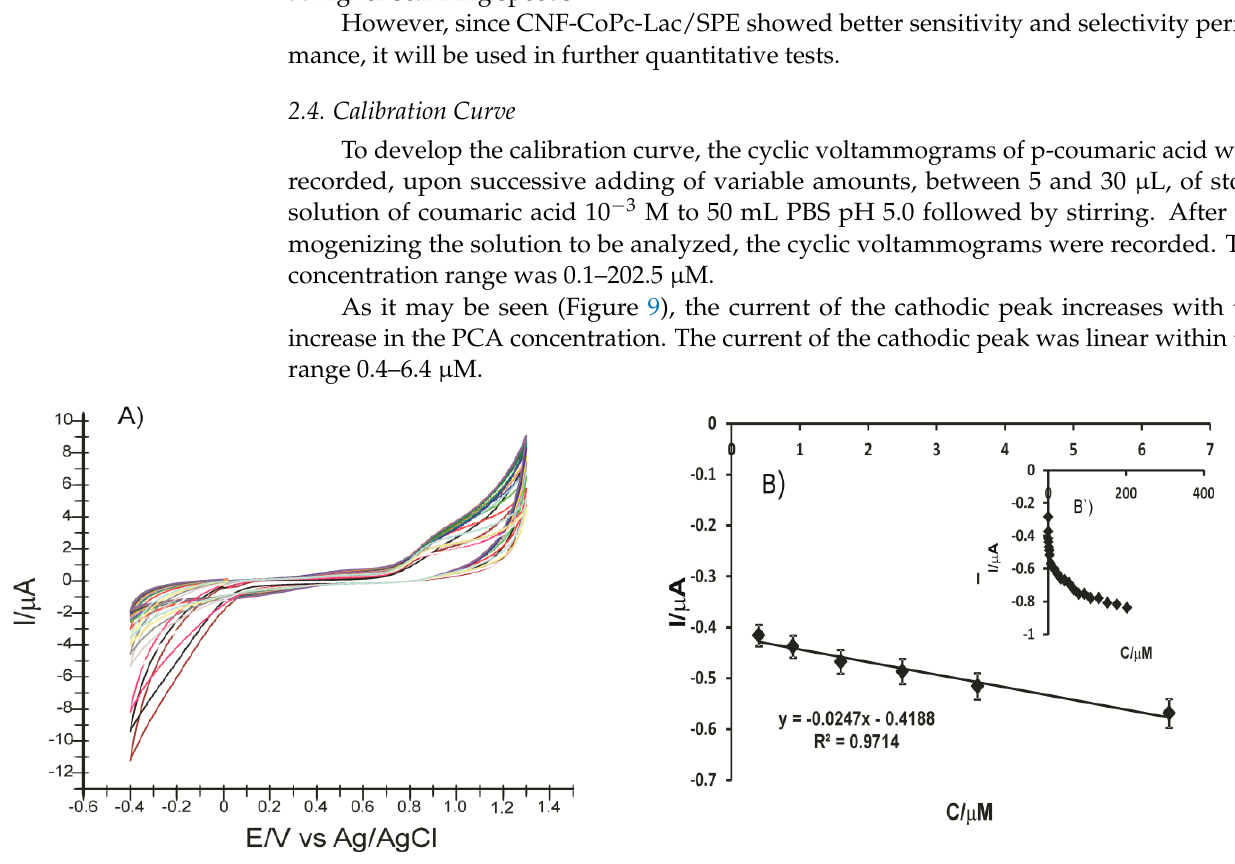
Figure 9. ( A ) Cyclic voltammograms recorded for CNF-CoPc-Lac/SPE on the concentration range 0.1–202.5 µ M p-coumaric acid. Linear fitting within the range 0.4–6.4 µ M ( B ) and 0.1–202.5 µ M ( B ) for CNF-CoPc-Lac/SPE.